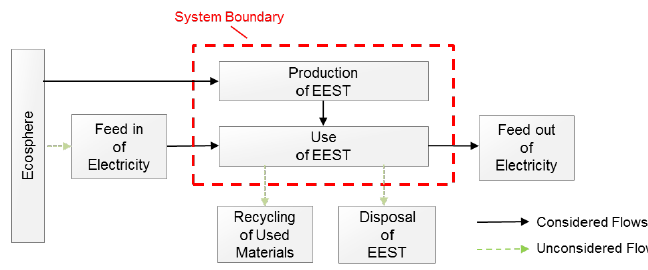
Figure 1. Product system, system boundary and flows.